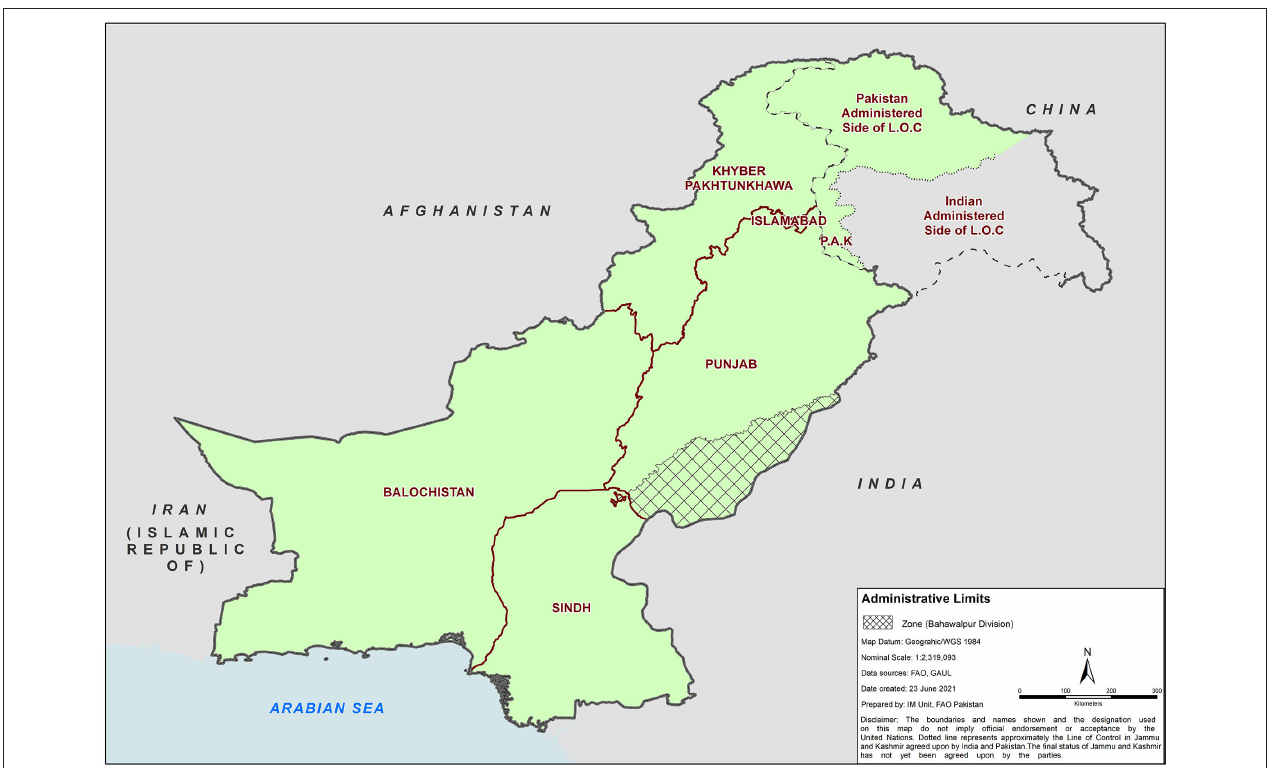
FIGURE 1 | Geographical representation of the perceived foot-and-mouth disease (FMD) control zone in Punjab province bordered by the Sutlej River, Sindh province, and India. The zone encompasses the entirety of Bahawalpur Division, with the Sutlej River forming the Northern barrier of the zone between the zone and the rest of Punjab